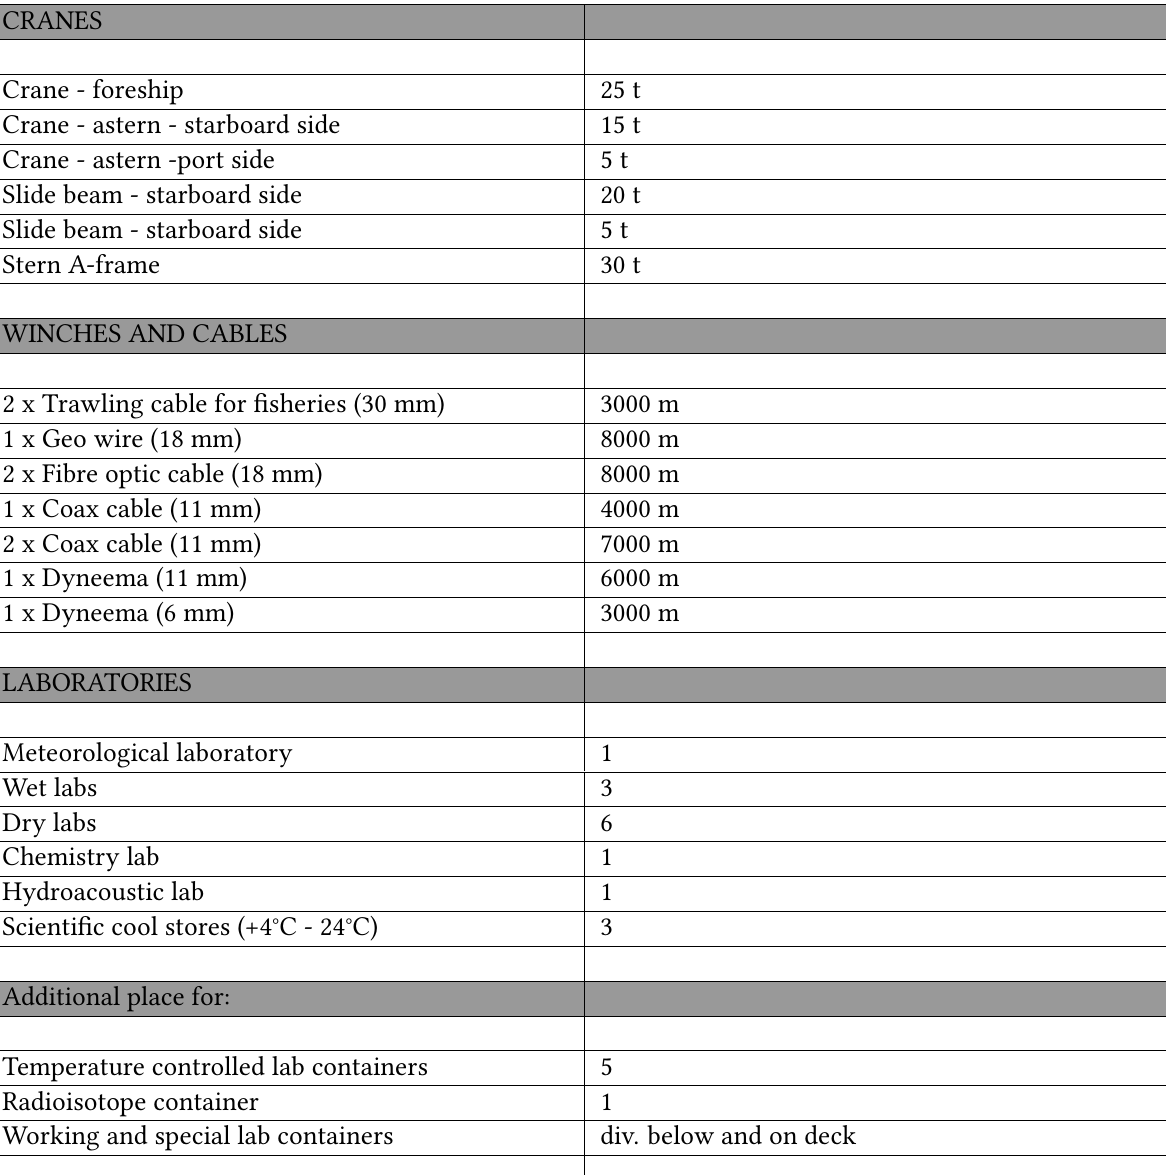
Table 2: Infrastructure for scientific work on